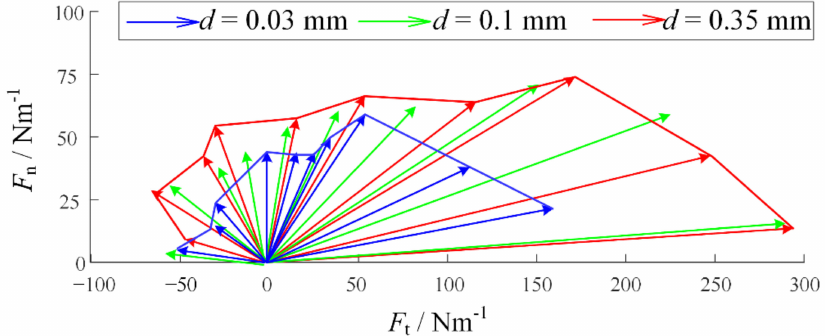
Figure 9. Disposal distribution at different beaded angles.